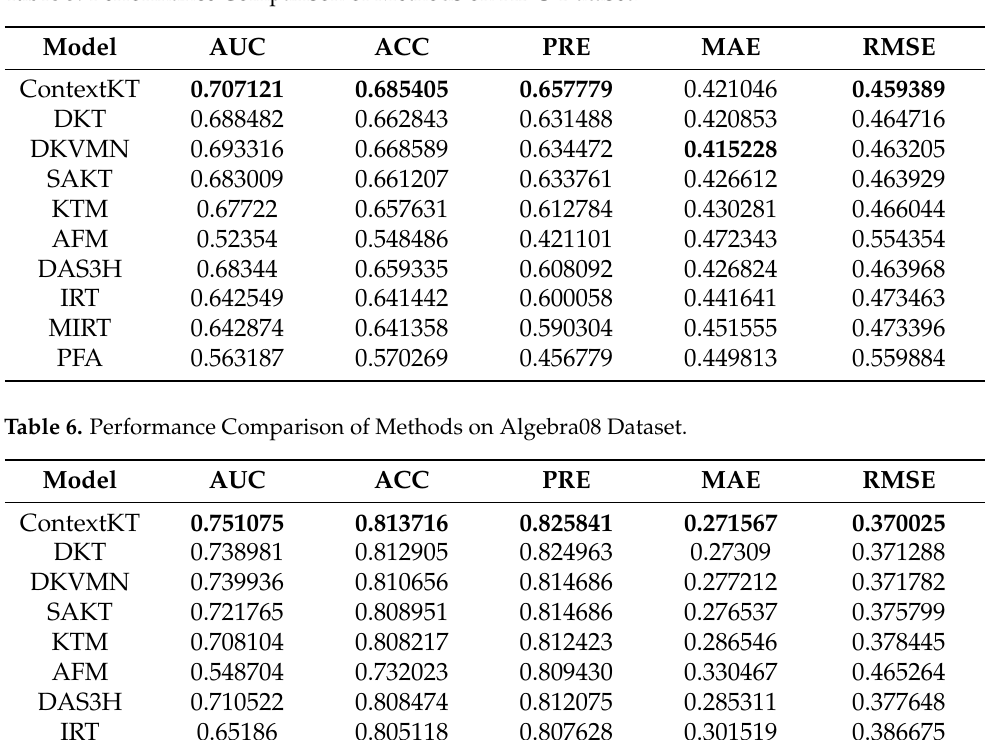
Table 5. Performance Comparison of Methods on HDU Dataset.